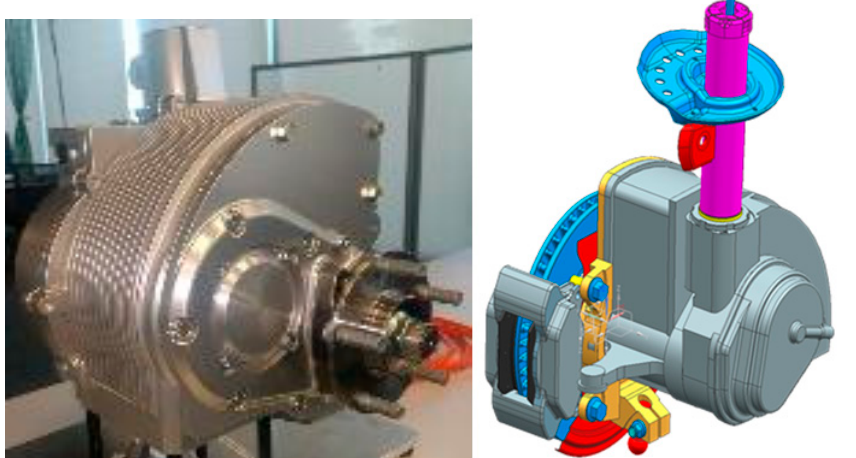
Figure 1. Proposed in-wheel motor system. The system includes DC capacitor, inverter, controller, and reduction gears in the unit. Natural air cooling is used to continuously output 20 kW drive.